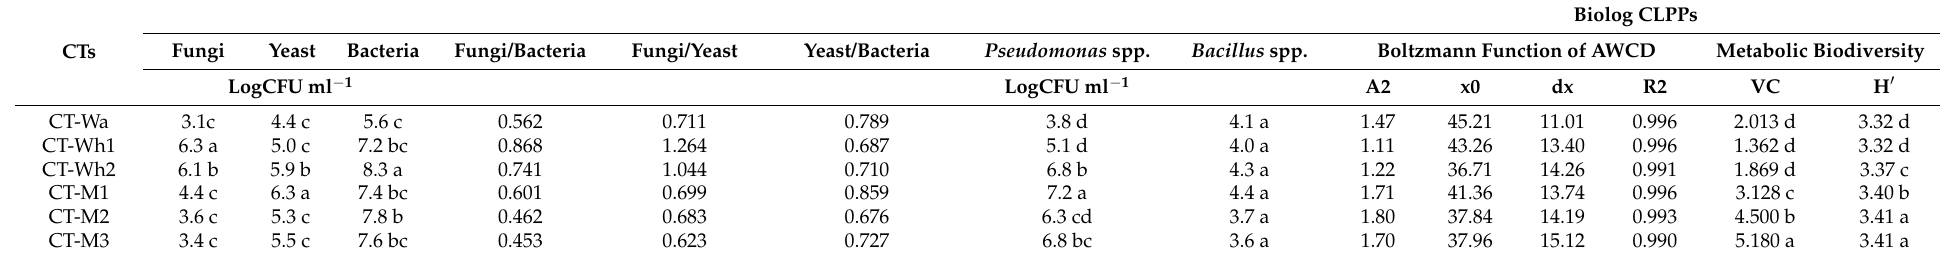
Table 7. Microbial population and levels of physiological profiles of CT communities detected by Biolog Eco Plate system. In each group, values followed by different lowercase letters were significantly ( p ≤ 0.05) different.